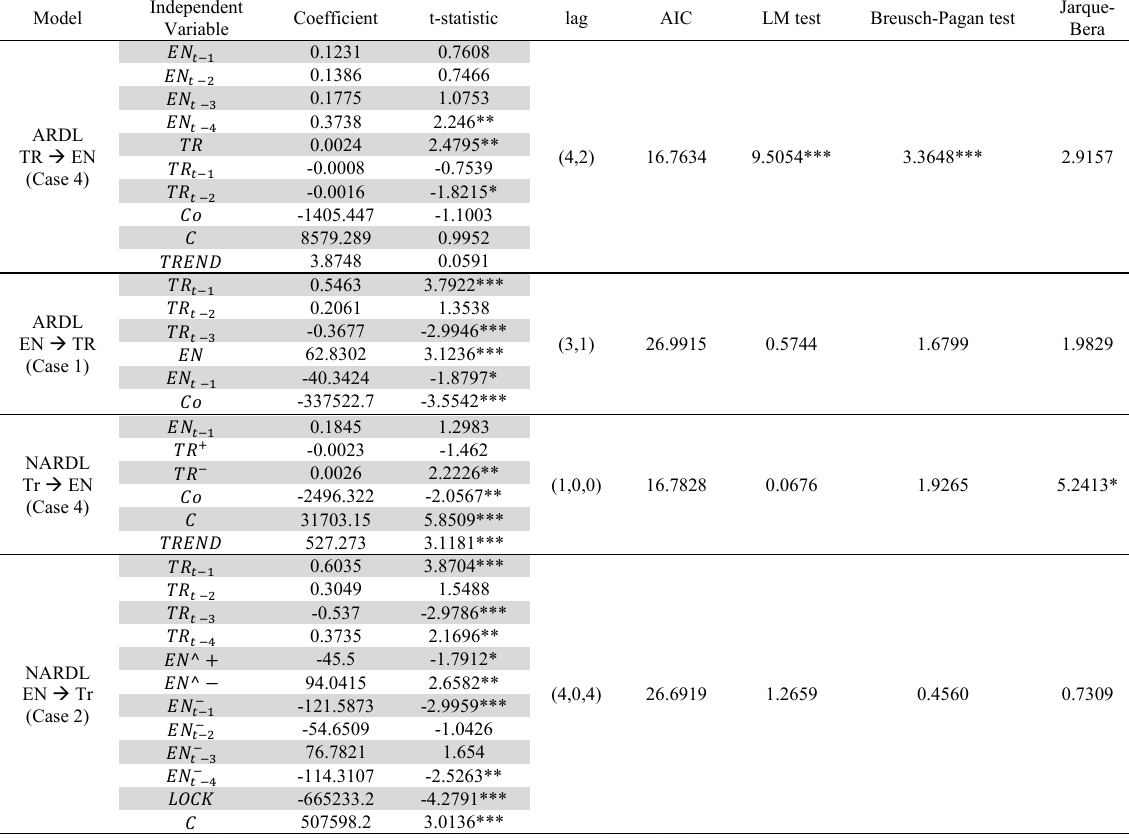
ARDL and NARDL regression models